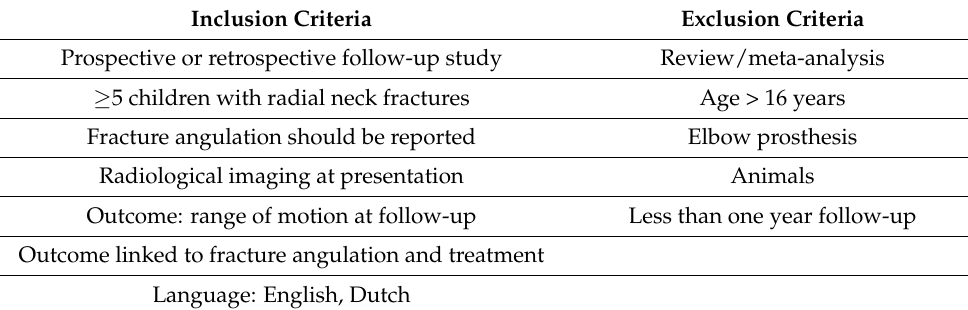
Table 1. Inclusion and exclusion criteria.